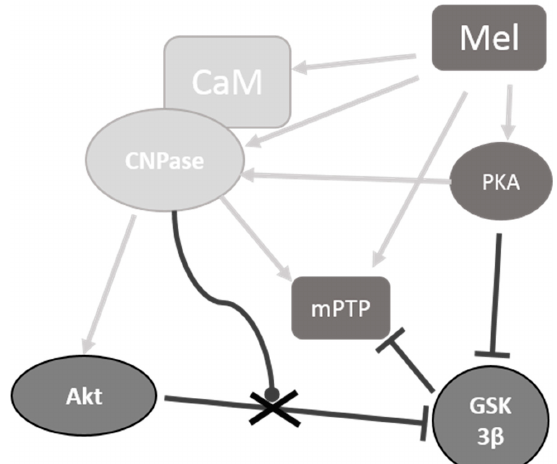
Figure 6. A hypothetical scheme of the involvement of melatonin (MEL) and CNPase in the regulation of mitochondrial permeability transition pore (mPTP) functioning. The figure shows possible protein phosphorylation-mediated mechanisms in rat brain mitochondria. According to our concept, CNPase, which is a target of the action of MEL, is capable to participate in the regulation of signaling pathways in mitochondria by changing the level of phosphorylation. In particular, CNPase and MEL are involved in the regulation of mPTP thereby inducing its opening. The regulation of mPTP opening is mediated through the phosphorylation by protein kinase A (PKA) and implies the participation of stress kinases (AKT and GSK 3 β ). CNP and MEL are also capable of binding CaM, indicating their involvement in calcium signaling and cAMP signaling